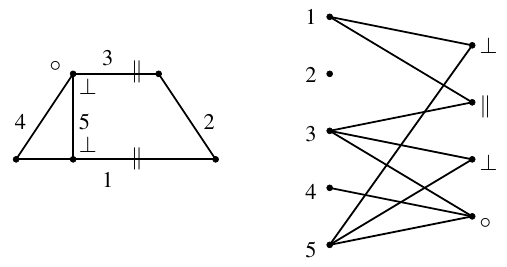
Figure 4. Left: Straight line segments and constraints. Right: Corresponding bipartite constraint